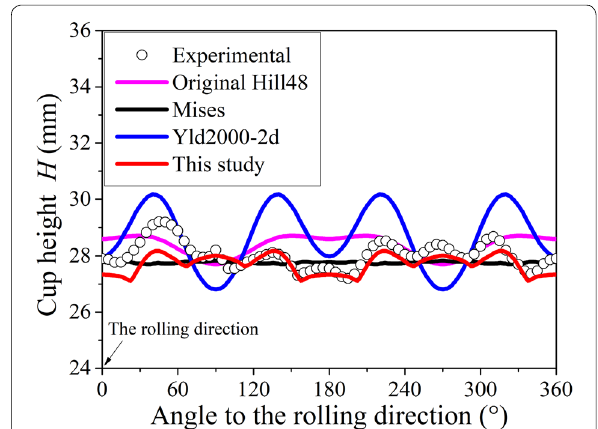
Figure 7 Comparison of simulation results and experimental results based on shell element